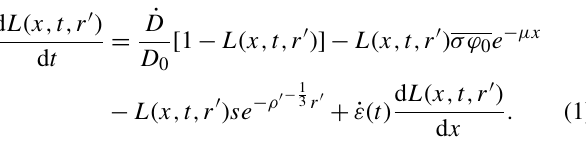
Characteristic dose of saturation